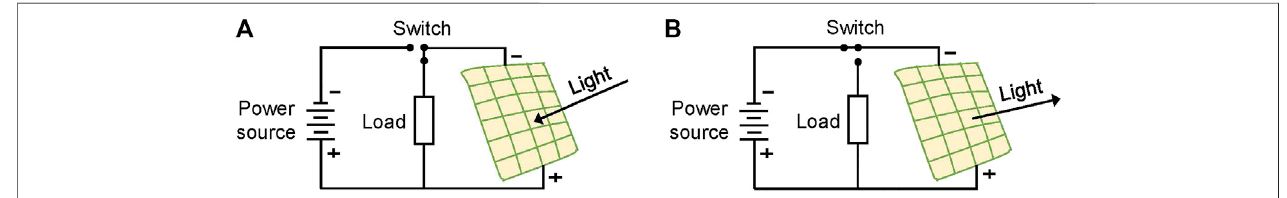
FIGURE 2 | Demonstrated circuit diagram of the proposed OWPT system with a perovskite transceiver: (A) receiver mode; (B) transmitter mode.